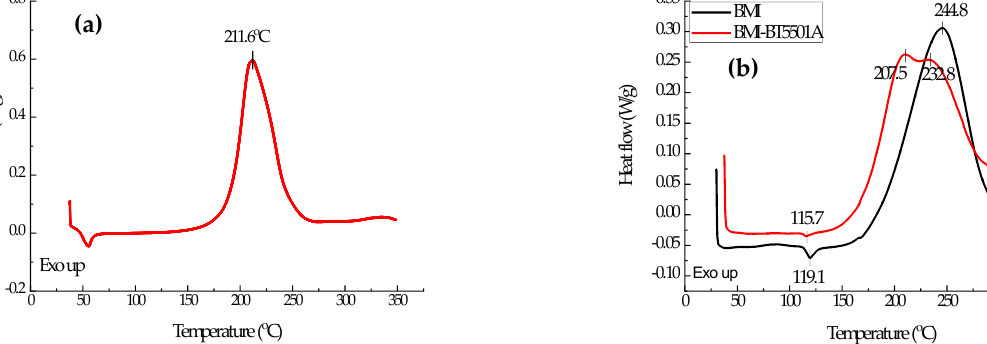
Figure 2. DSC curves of the benzoxazine-based BT5501A tackifier ( a ), bismaleimide, and bismaleimide–BT5501A composite resin ( b ).